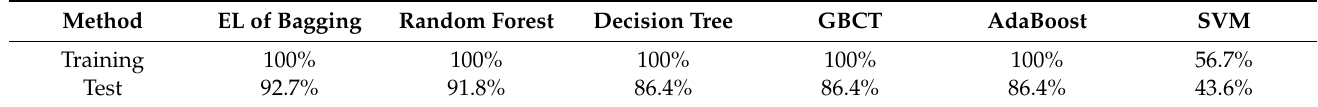
Table 9. Diagnosing accuracy of each